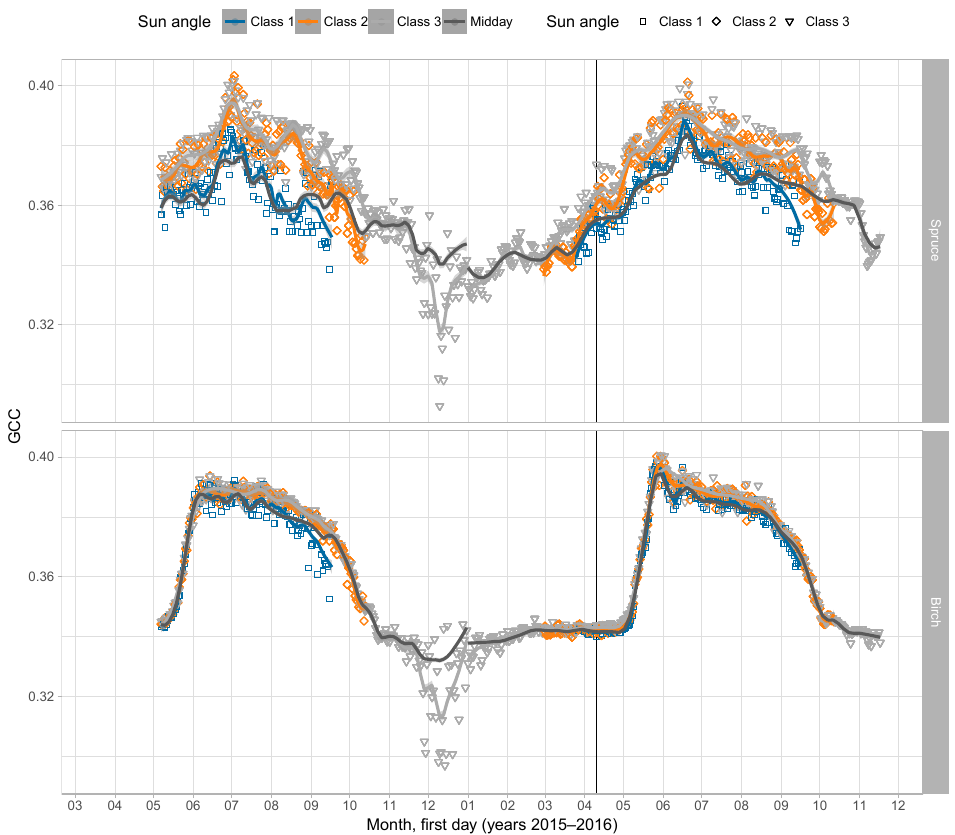
Figure 5. Daily GCC time series of ROI in Parkano site by solar elevation category – class 1: >30 ◦ ; class 2: (20, 30 ◦ ); class 3: (0, 20 ◦ ) – and as daytime averages (midday: 10:00–14:00UTC + 2) and smoothed development of GCC over the years. Vertical line shows the snowmelt date, i.e. the first day without any snow. In 2015 snow had melted before the camera was